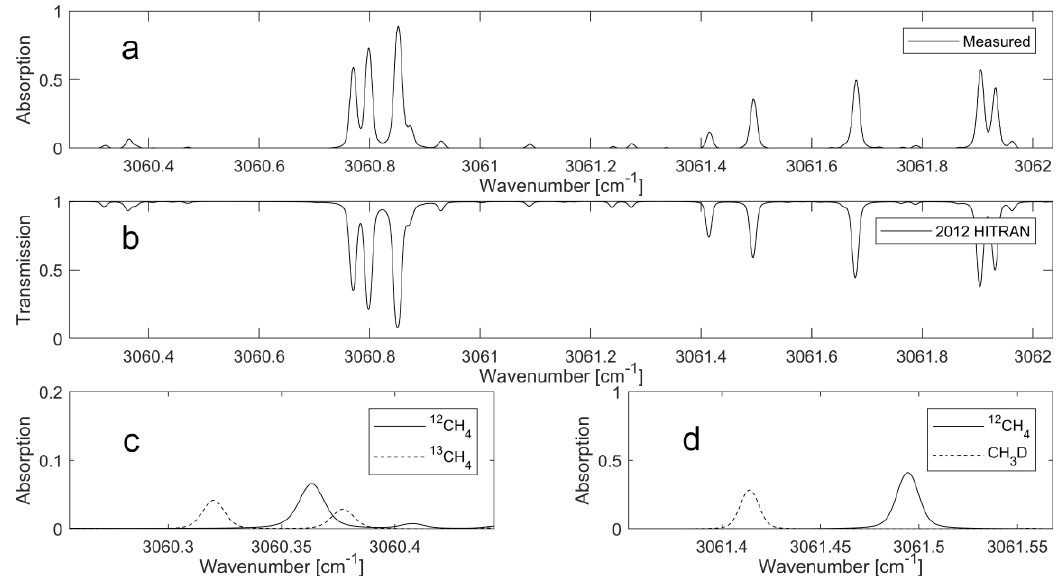
Figure 1. Absorption spectrum, averaged from 10 interband cascade lasers (ICL) current sweeps ( a ); simulated spectrum using the 2012 HITRAN database ( b ); simulated spectrum of the 12 CH 4 and 13 CH 4 line pair ( c ); and 12 CH 4 and CH 3 D line pair ( d ).